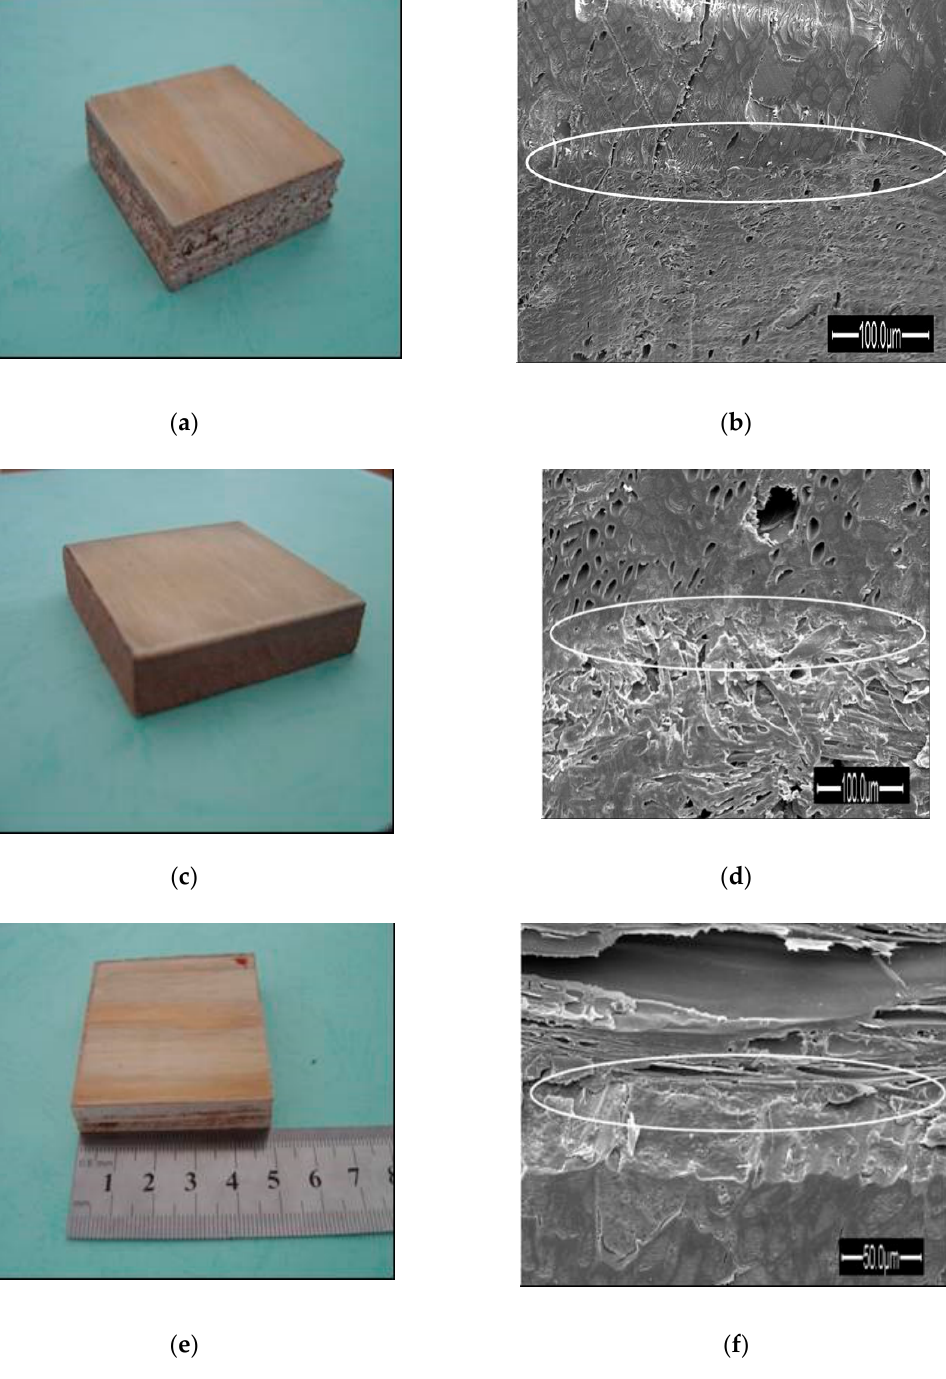
Figure 5. The digital photos ( a , c , e ) of the three modified veneer-decorated wood-based panel composites and their SEM morphologies of the bonding interface ( b , d , f ). The digital photo ( a ) of the modified veneer-decorated particleboard composite and the SEM morphology of the bonding interface ( b ). The digital photo ( c ) of the modified veneer-decorated fiberboard composite and the SEM morphology of the bonding interface ( d ). The digital photo ( e ) of the modified veneer-decorated plywood composite and the SEM morphology of the bonding interface ( f ).